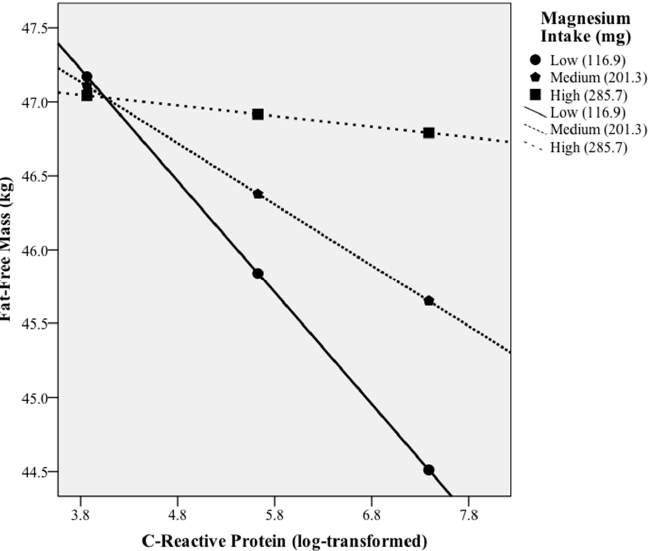
Figure 1. Moderation of high ‐ sensitivity C ‐ reactive protein and fat ‐ free soft tissue by magnesium intake. Low = 1 standard deviation below the mean of magnesium intake. Medium = mean of mag ‐ nesium intake. High = 1 standard deviation above the mean of magnesium intake. N =